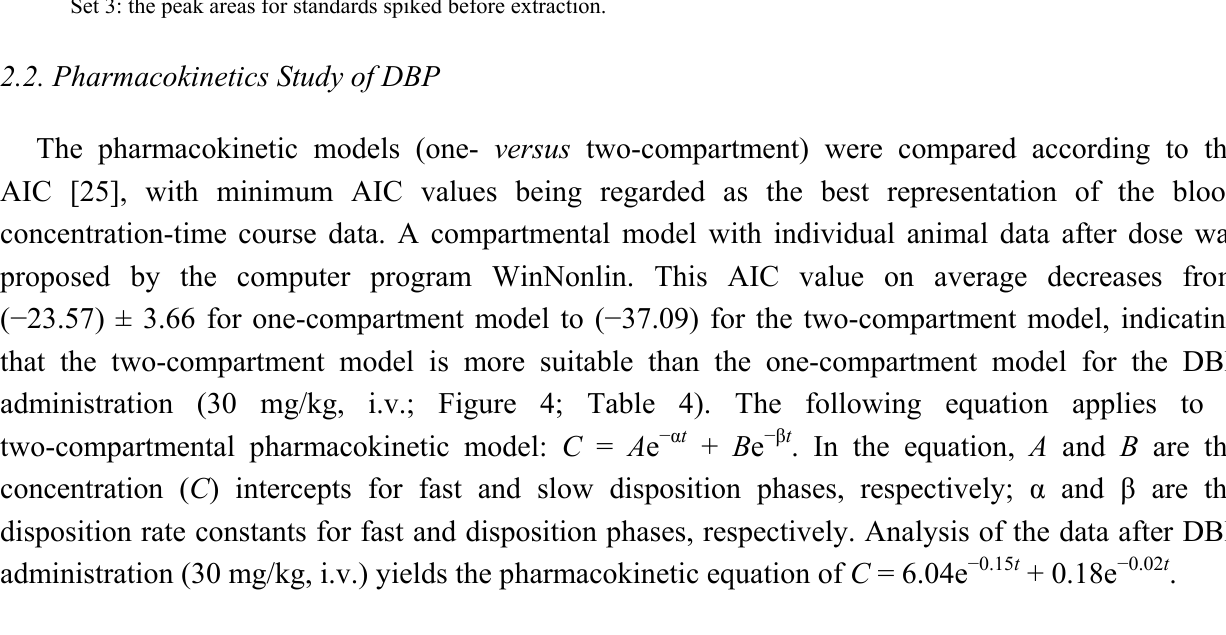
IS (1 μ g/mL) in feces